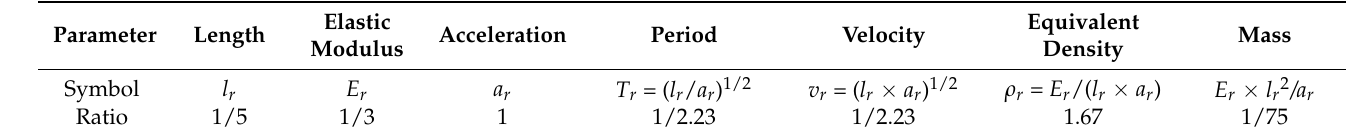
Table 3. The mass parameters of individual stories and the artificial